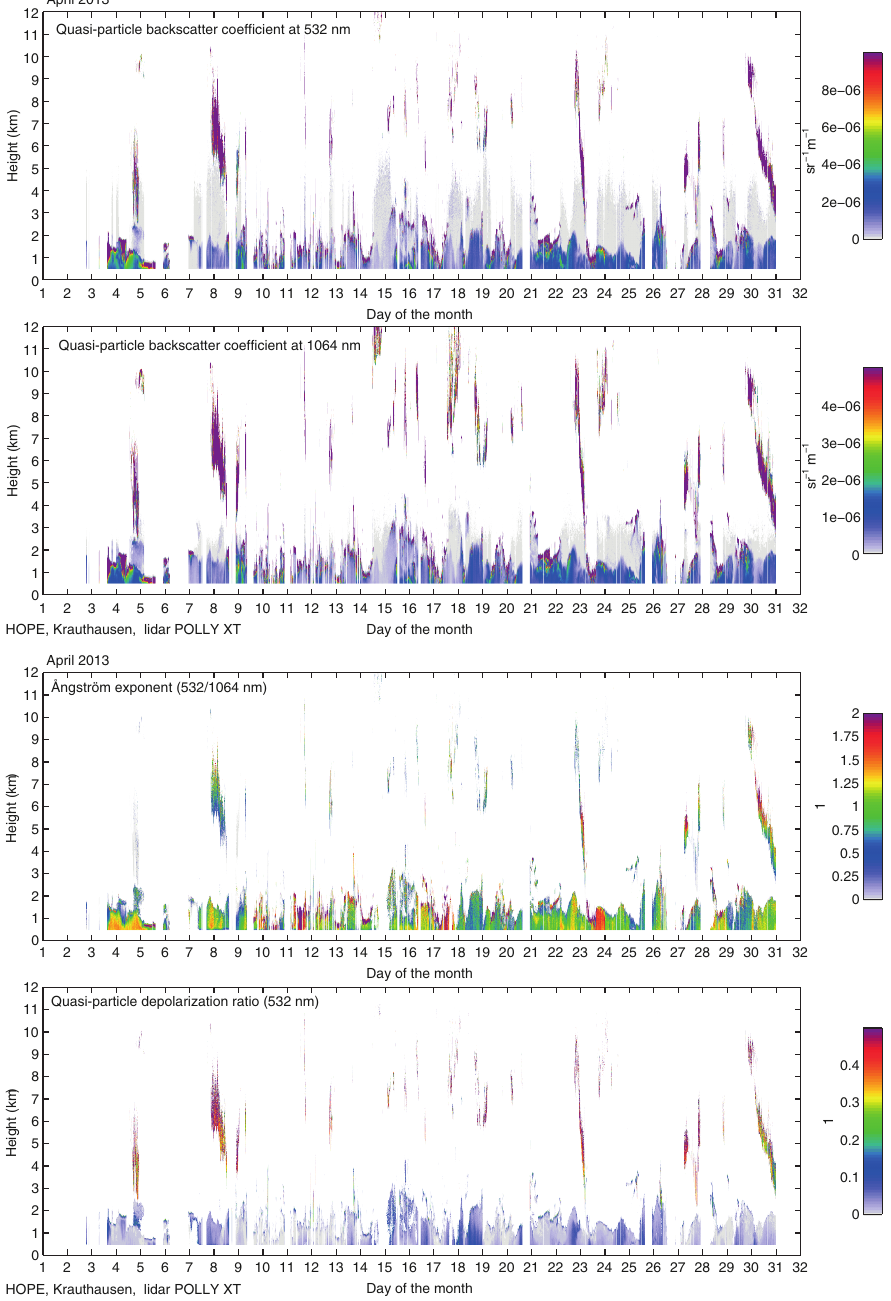
Figure A1. Overview of MWL Polly XT observations in April 2013. Top to bottom: quasi-particle-backscatter coefficient at 532 and 1064nm, corresponding Ångström exponent, and quasi-particle de- polarization ratio at